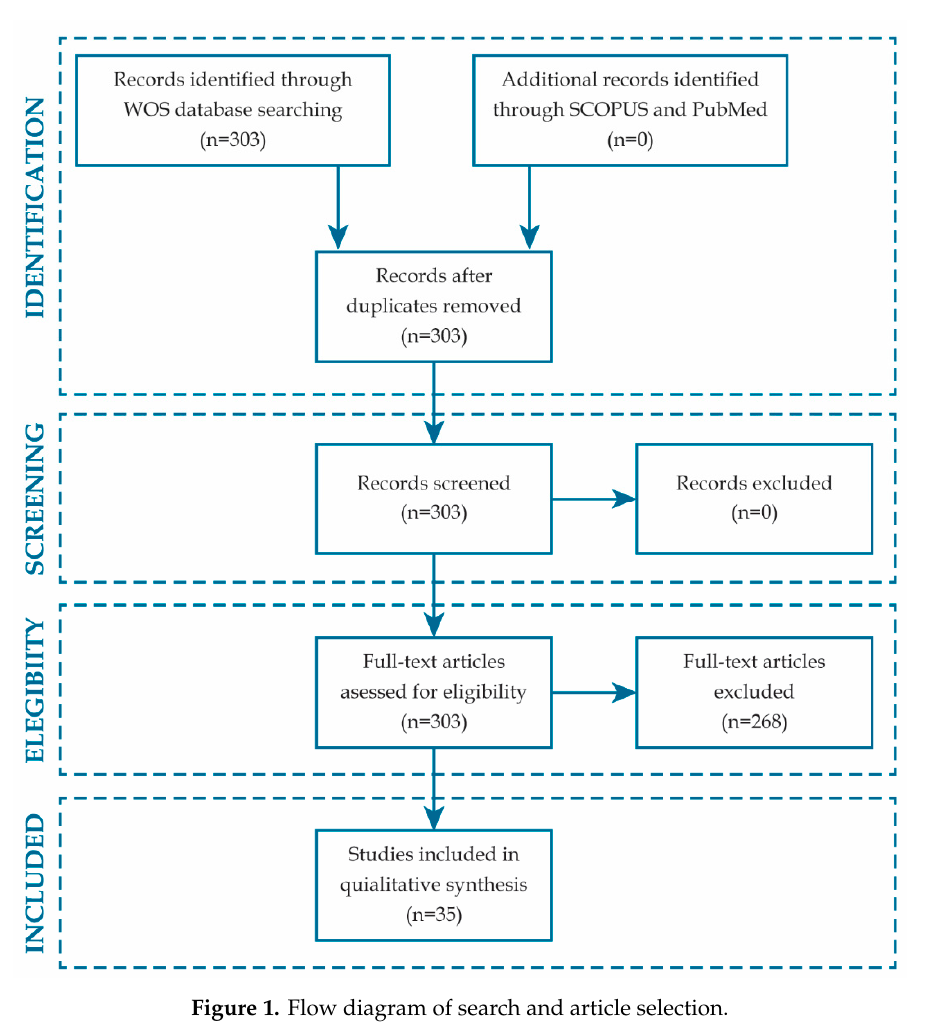
Figure 1. Flow diagram of search and article selection.